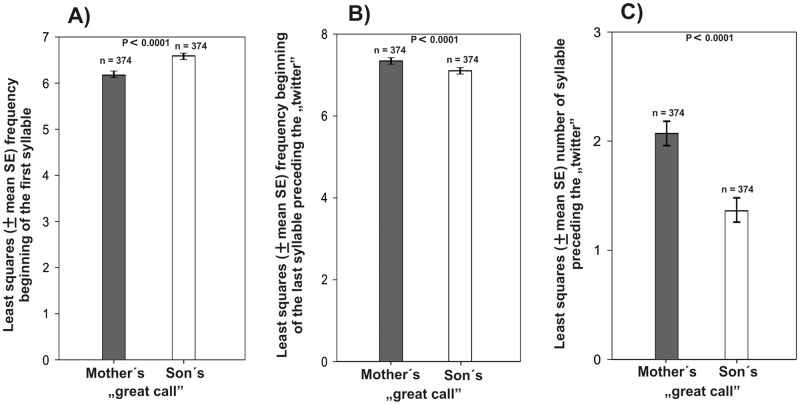
Differences in characteristics of adult female´s and their son´s “great calls” (least squares mean ± SE).A) start frequency of the first syllable, B) start frequency of the last syllable, and C) number of syllables preceding the”twitter”.